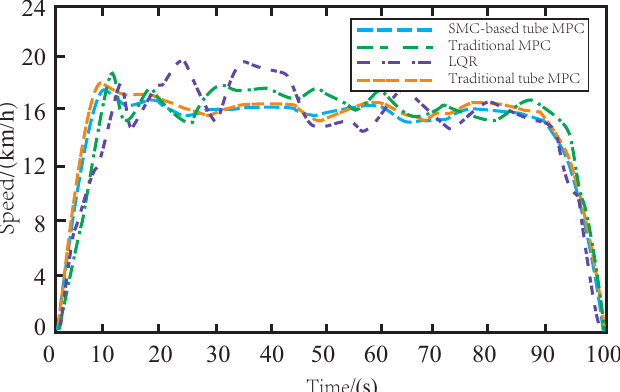
Figure 6. The variation of speed on the muddy road.